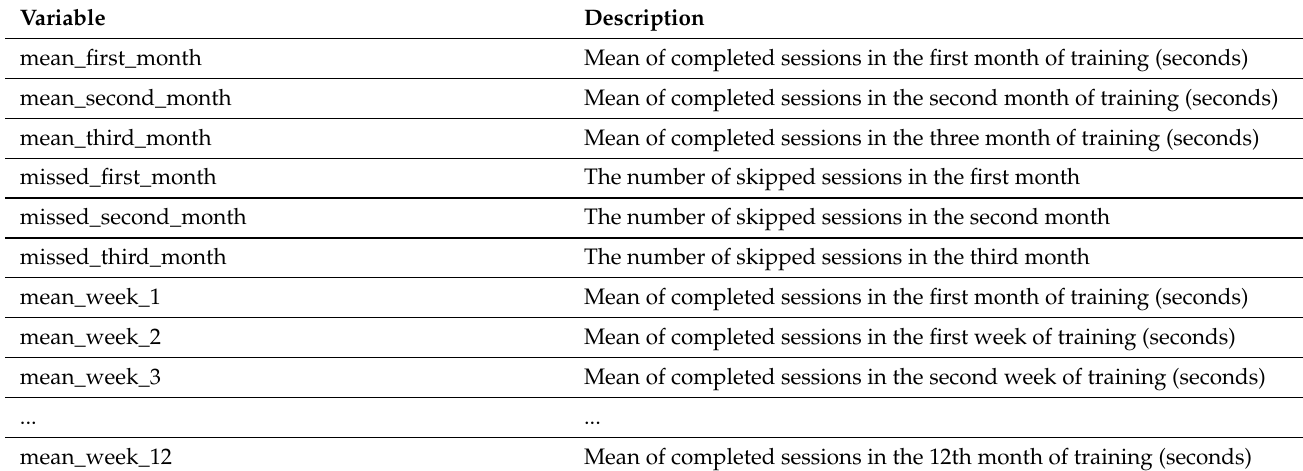
Table 11. Description of features used for